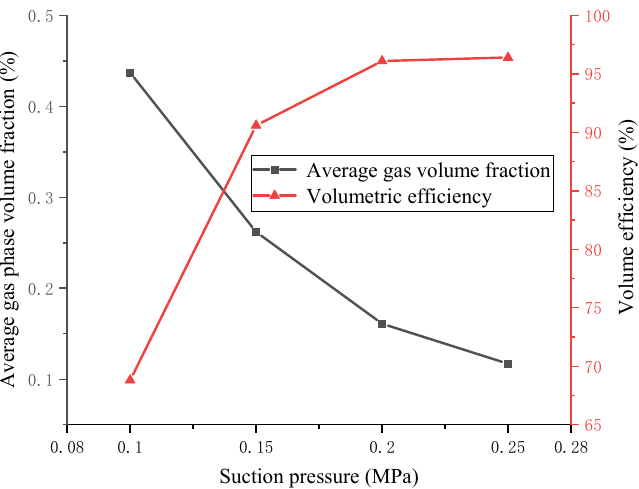
Figure 15. Average gas volume fraction and volumetric efficiency at different suction pressures.